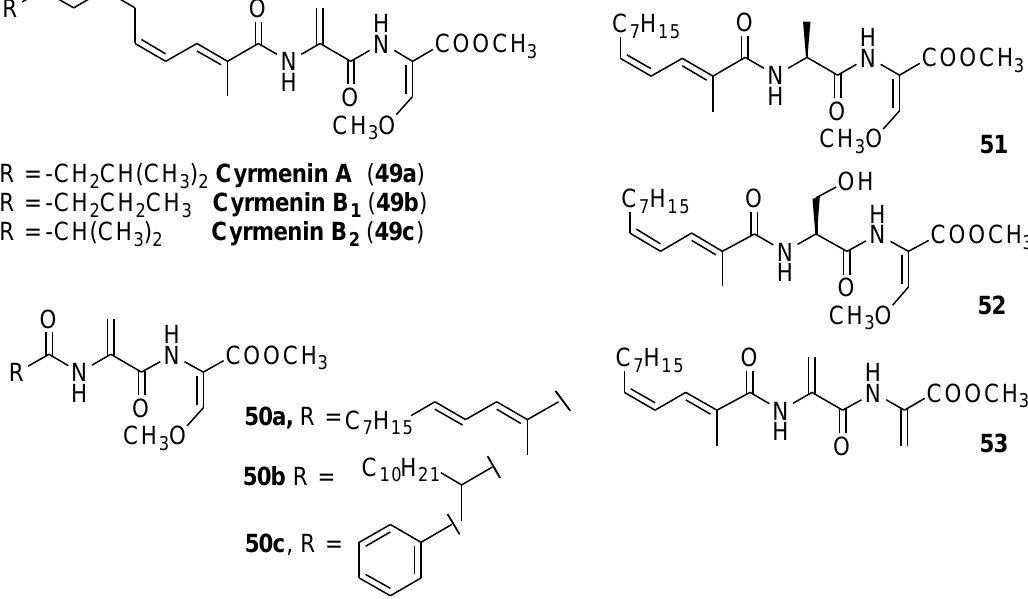
Figure 14. Structure of natural cyrmenins and analogs.